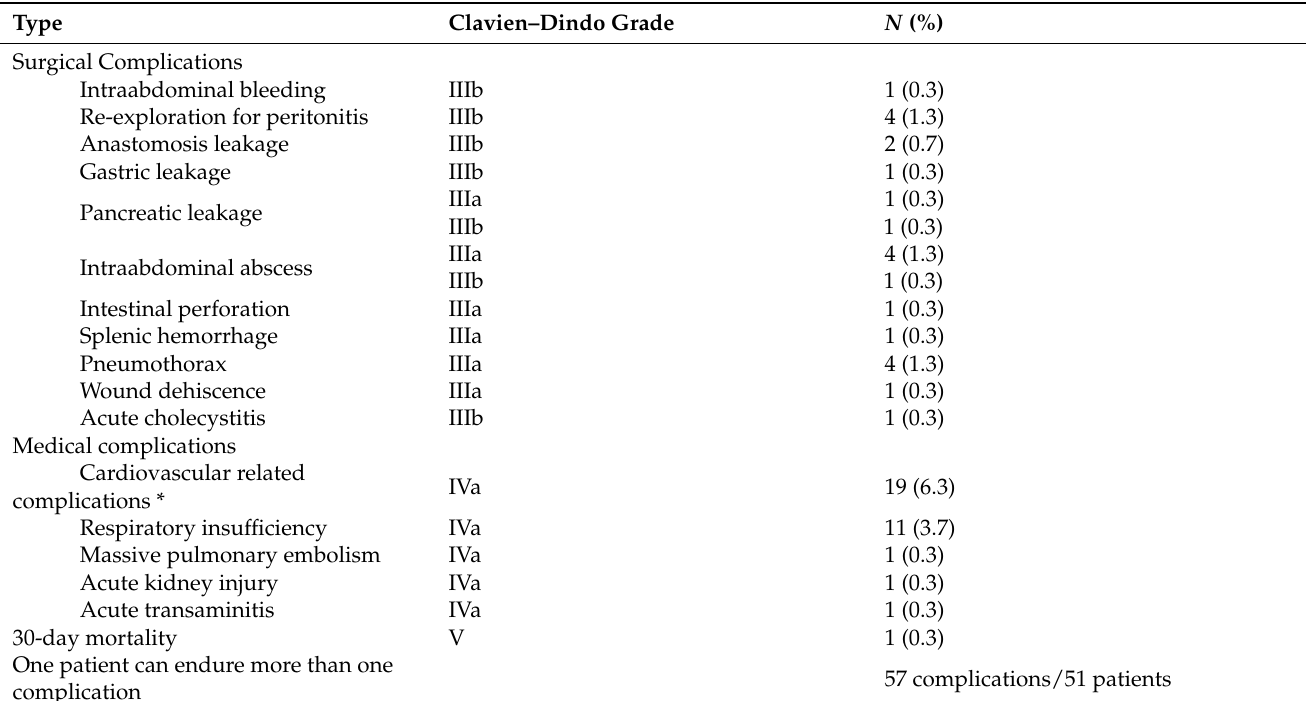
Table 2. Type and frequency of 30-day Clavien–Dindo grade ≥ IIIa complications ( N =